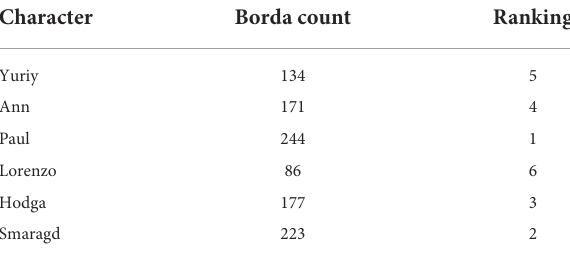
TABLE 9 Global ranking given by the Borda count. Character Borda count